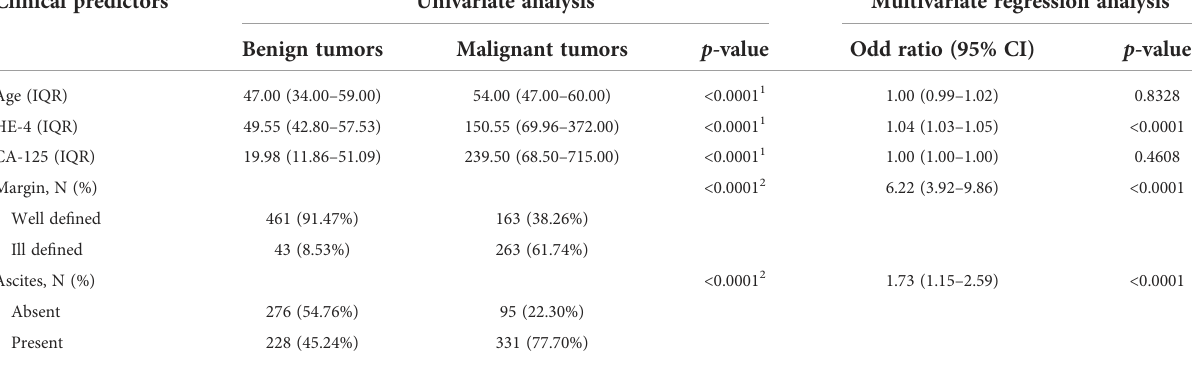
TABLE 3 Results of univariate analysis and multivariate logistic regression analysis for clinical predictors in the training cohort. Clinical